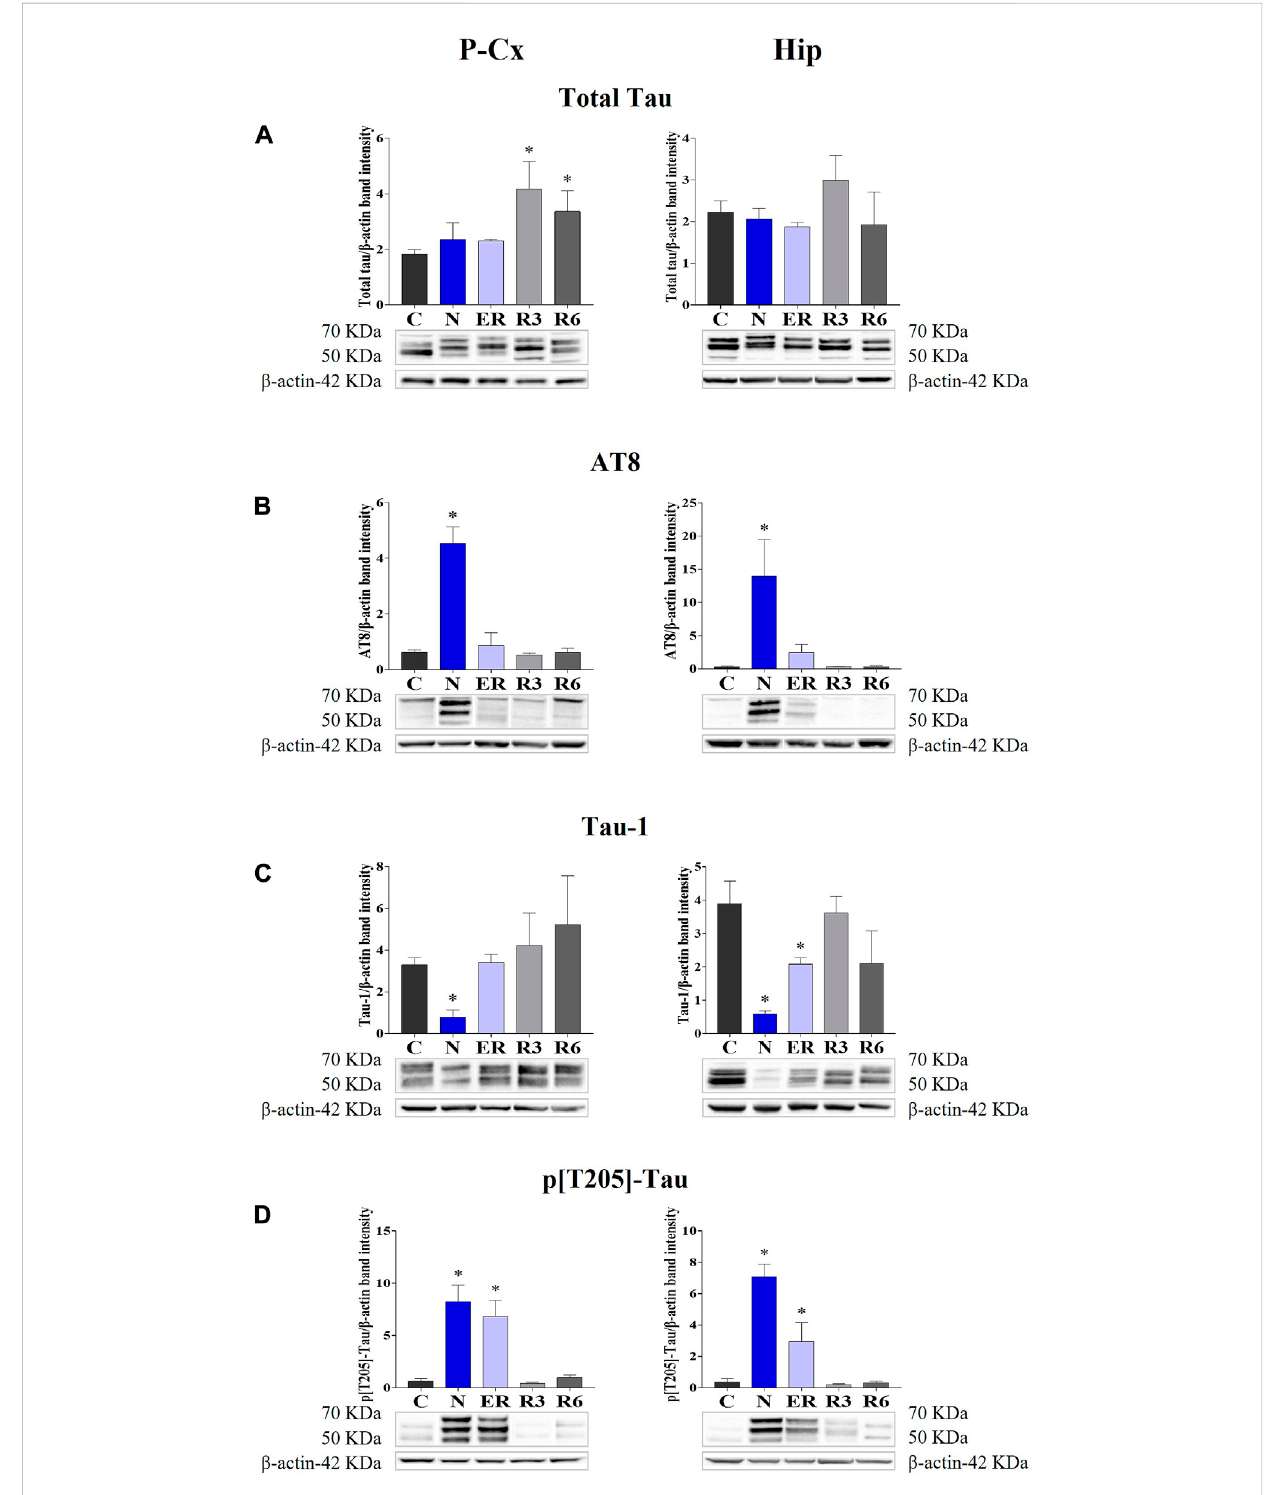
FIGURE 2 Western blot detection of Total Tauand dephosphorylated/phosphorylated formsof Tauproteinlevels inbrain extractsof theparietal cortex(P-Cx) andhippocampus(Hip).Beloweachhistogram,WBrepresentativesamplesareshownforeachexperimentalcondition. (A) TotalTauprotein; (B) AT8(Tau phosphorylated at Ser202 and Thr205); (C) Tau-1 (Tau dephosphorylated between 189 and 207 residues); (D) p[T205]-Tau (Tau phosphorylated at Thr205). Data are normalized by β -actin and expressed as means ± S.E.M., n = 3. *: p < 0.05 vs. C. Experimental groups (see Figure 1): C, control; N, samplestakenatnadirofhypothermia,duringST;ER,earlyrecovery,samplestakenwhenTbreached35.5 ° CfollowingST;R3,samplestaken3 hafterER; R6, samples taken 6 h after